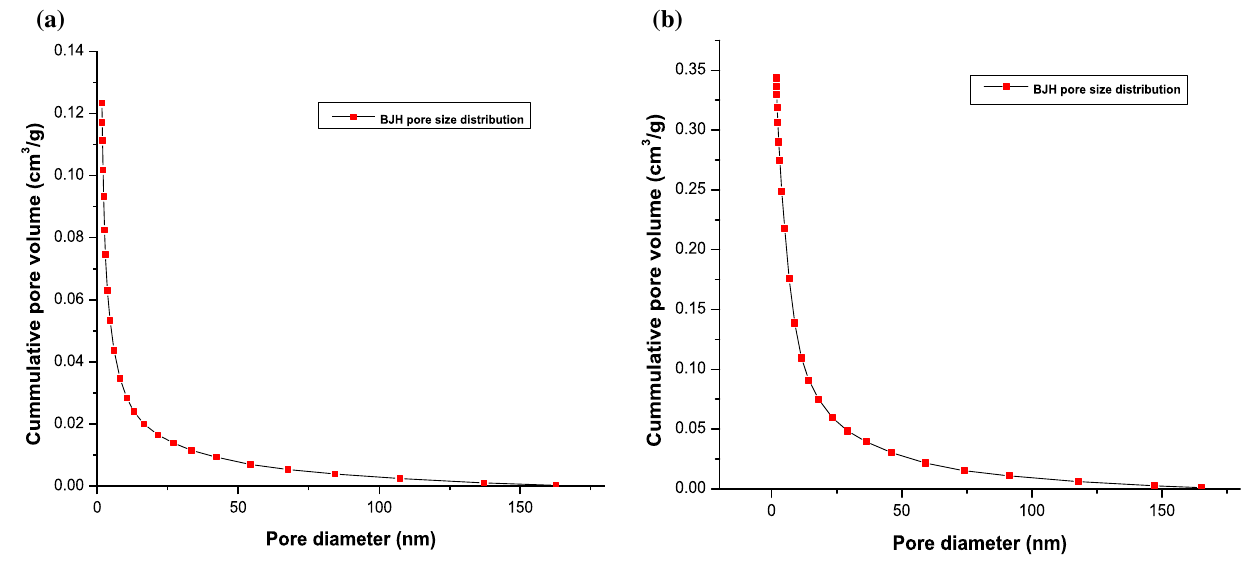
Fig. 5 Pore size distribution of a AWS (before activation) and b KOHAWS (after